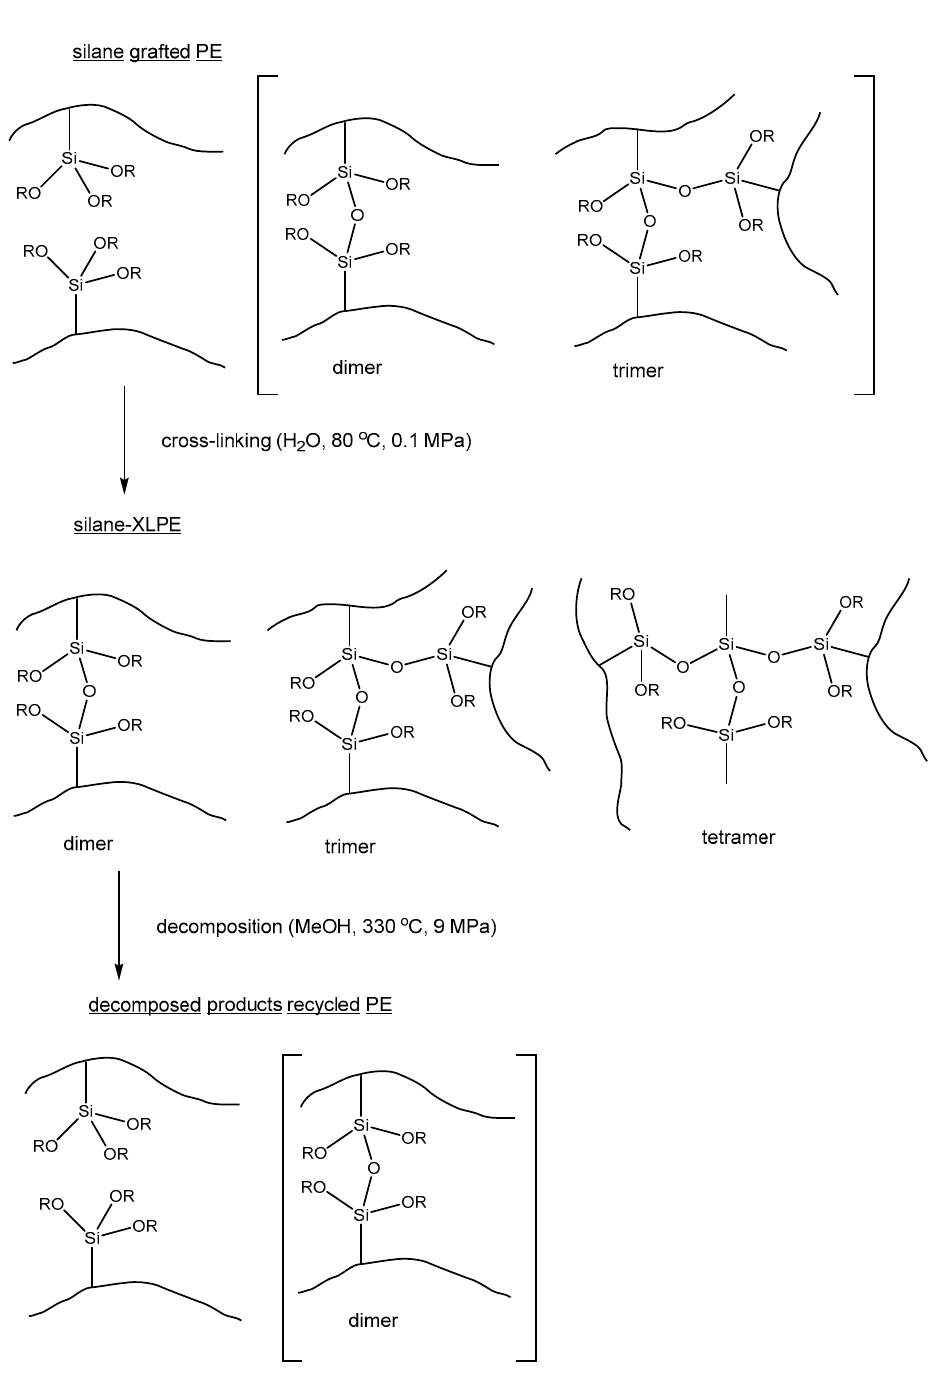
Figure 5. Chemical structures of the silane-XLPE precursor (upper image), silane-XLPE crosslinked product, and selective silane cleavage product (bottom image). Adapted from Ref. [64] with permission from Wiley, copyright 2008.